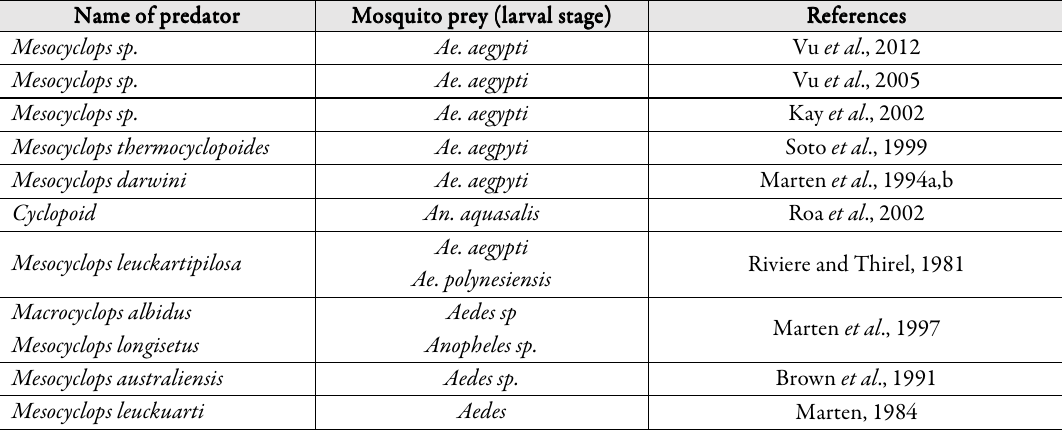
Table 2. List of aquatic predaceous copepods (Subphylum: Crustacea; subclass: Copepoda) and their